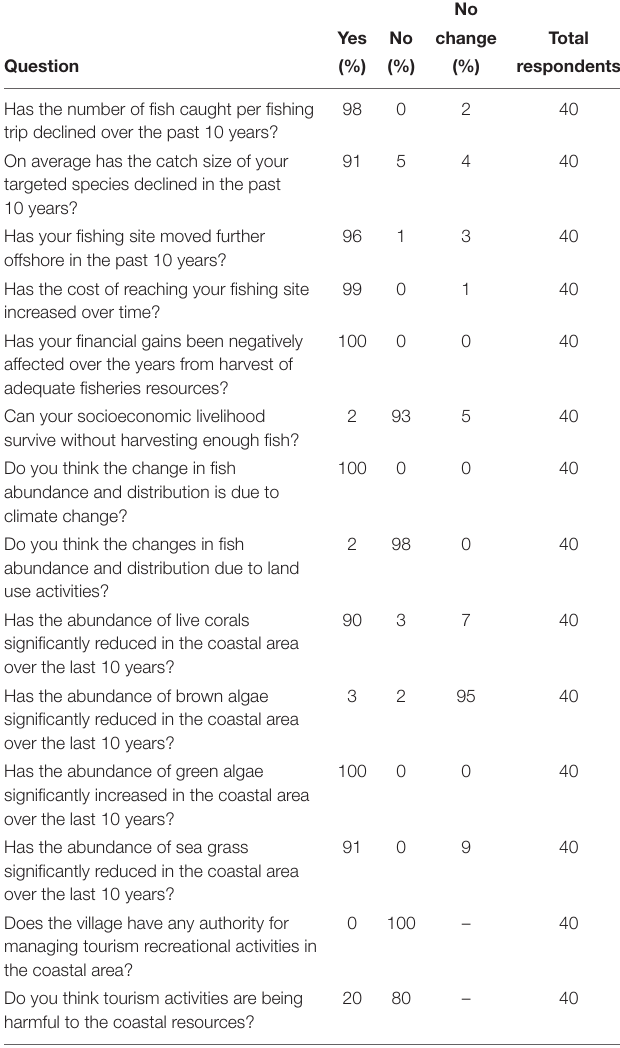
TABLE 1 | Confusion matrix results and accuracy assessment for benthic cover maps at Komave. Producers Users Overall Kappa Percentage